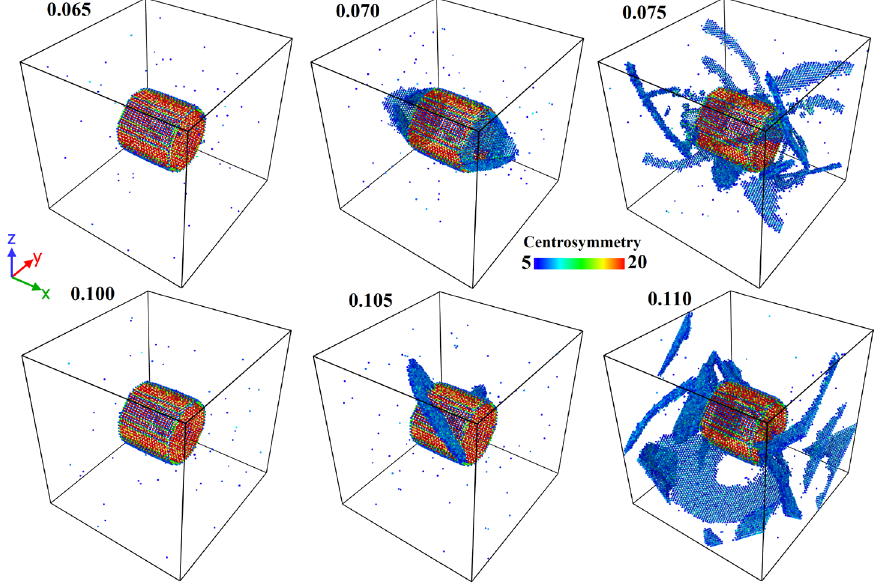
Figure 3. Plasticity incipience (nucleation of dislocations) in aluminum single crystals with cylindrical nanopores equivalent to 8 nm. Top and bottom panels represent two different deformation paths; the current values of the engineering strain are shown near the atomic configurations. The color scheme is the same as in Figure 2.